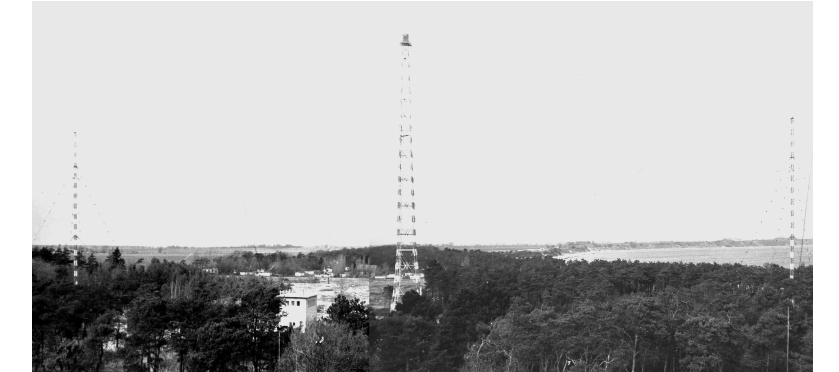
Figure 21. The towers bearing the transmitting and receiving antennas of the ionosonde, used from 1964. The freestanding central tower stands 70m high, and the outer guyed towers stand 52m high.